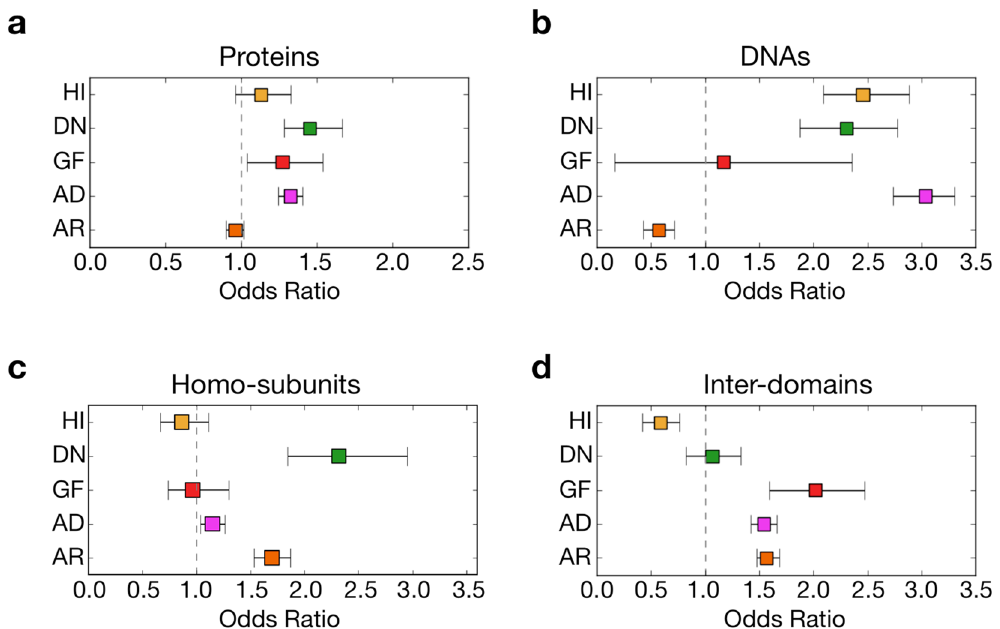
Figure 2. Odds ratio of mutations on interfaces for each inheritance mode. ( a – d ) The odds ratio distributions of probabilities that mutations in a category occurred in a given interface of proteins ( a ) or DNA ( b ). ( c ) The ratios of mutations being used for homo over hetero subunit interactions. ( d ) The ratios of mutations used for domain